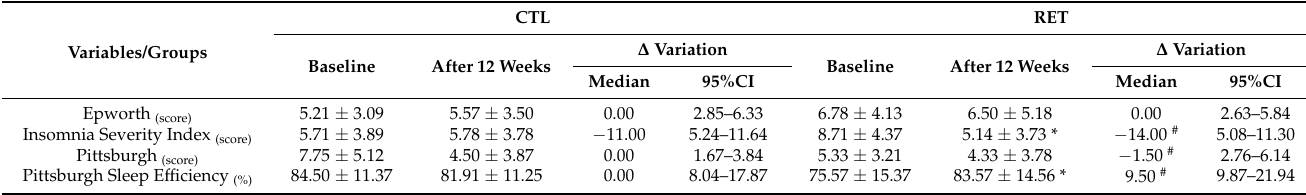
Table 3. Subjective sleep evaluation